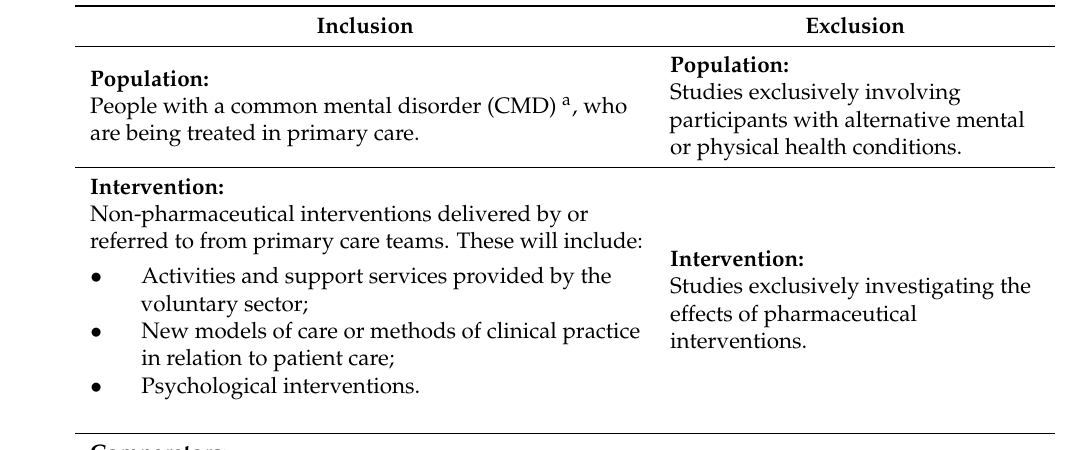
Table 1. Summary of inclusion and exclusion